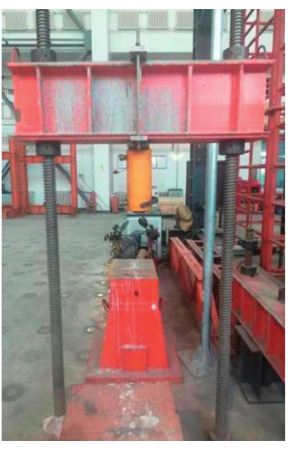
Figure 9: Loading equipment.